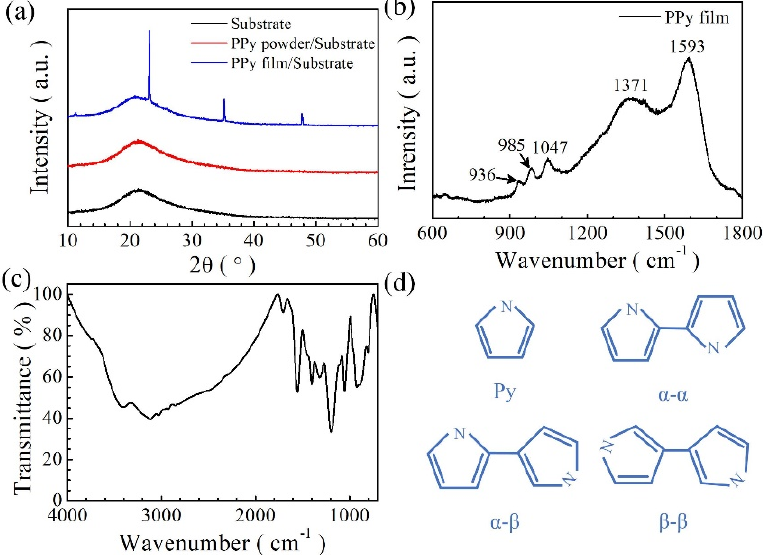
Figure 3. ( a ) XRD pattern of PPy film. ( b ) Raman spectrum of PPy film. ( c ) FTIR spectrum of PPy film. ( d ) Molecular formula and molecular connection form of pyrrole monomer.